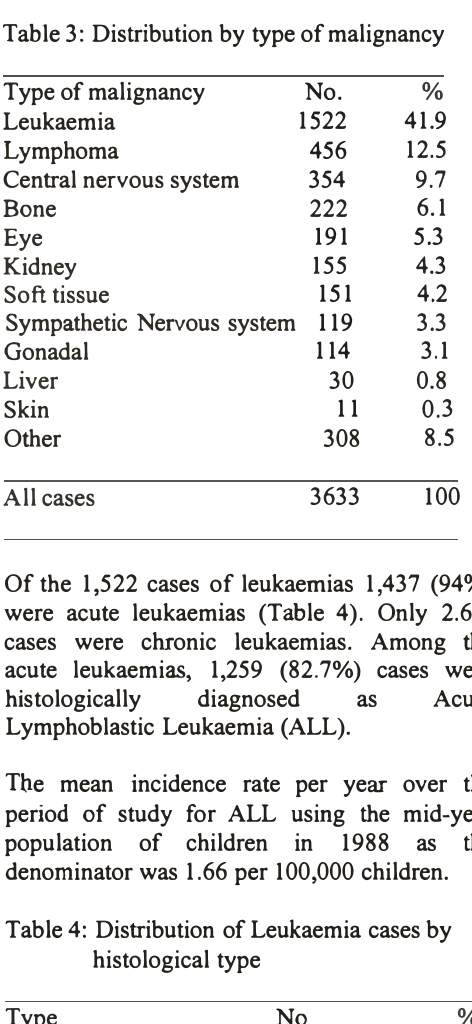
Table 3: Distribution by type of malignancy